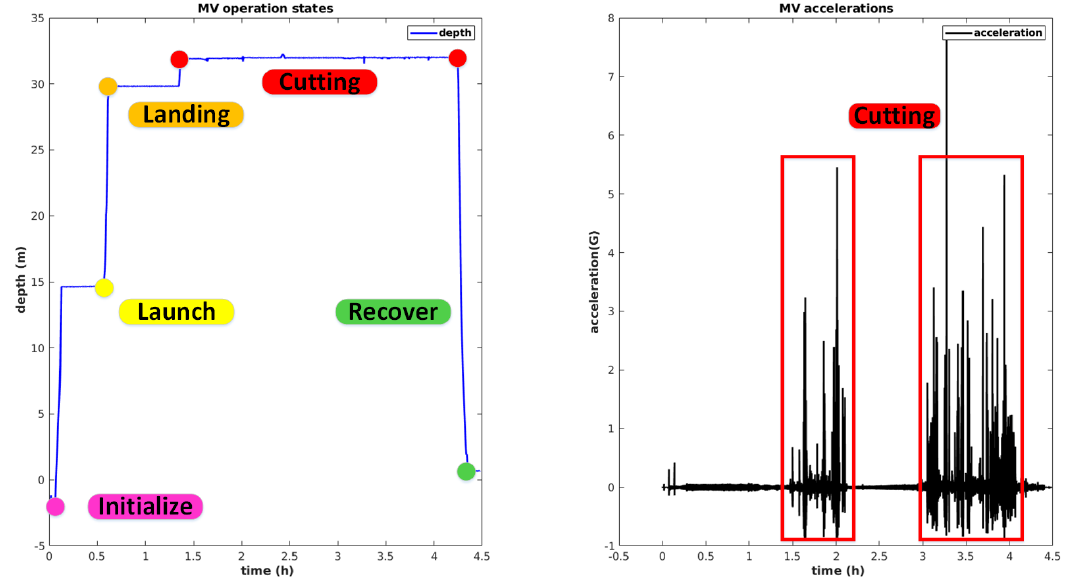
Figure 9. Summary of the mining vehicle mission: ( a ) representation of several mission phases; ( b ) acceleration values registered during the cutting